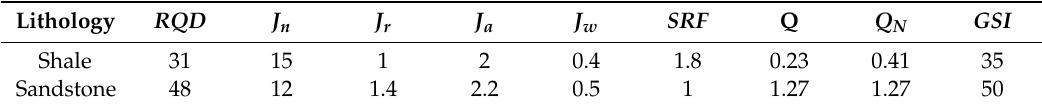
Table 4. Evaluating results using the Q-system.